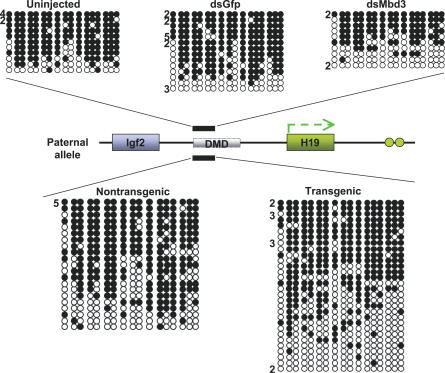
Reduction of Mbd3 in Embryos Results in a Loss of Methylation at the H19 DMDOne-cell C57BL/6J X B6(CAST7) embryos were injected with dsRNA, cultured to the blastocyst stage, and collected in pools of five blastocysts (top). Similarly, TG and NTG embryos were isolated at the one-cell stage, cultured to the blastocyst stage, and collected in pools of five (bottom). Bisulfite mutagenesis was performed on agarose-embedded pools of five blastocysts. CpGs (17) were assayed in the 5′ half of the DMD as indicated by the black line in the diagram in the center. Each line of circles represents a single DNA strand with the number to the left of the line corresponding to the number of times this pattern was seen. Each circle represents a single CpG. If the CpG was methylated, the circle is filled. Those strands with less than half of the CpGs methylated are considered hypomethylated. In control embryos, only a few hypomethylated strands are recovered (13% and 17% for uninjected and dsGFP-injected blastocysts, respectively), but in dsMbd3-injected embryos, 42% of the paternal strands are hypomethylated. TG RNAi blastocysts showed similar results with 42% of the paternal strands hypomethylated compared to 16% of the strands in NTG embryos. Only paternal strands are shown, as all sequenced maternal strands were unmethylated as expected. Although its expression also depends on the DMD, Igf2 is not expressed at this stage.